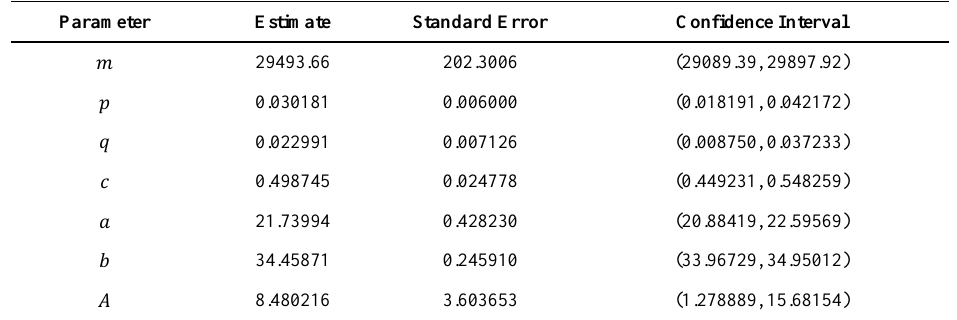
Table A26. Emilia–Romagna. Estimates, asymptotic standard errors and 95% mCIs for the parameters of the BeGBM 𝑹𝑬𝑪𝑻 (7)+(5).